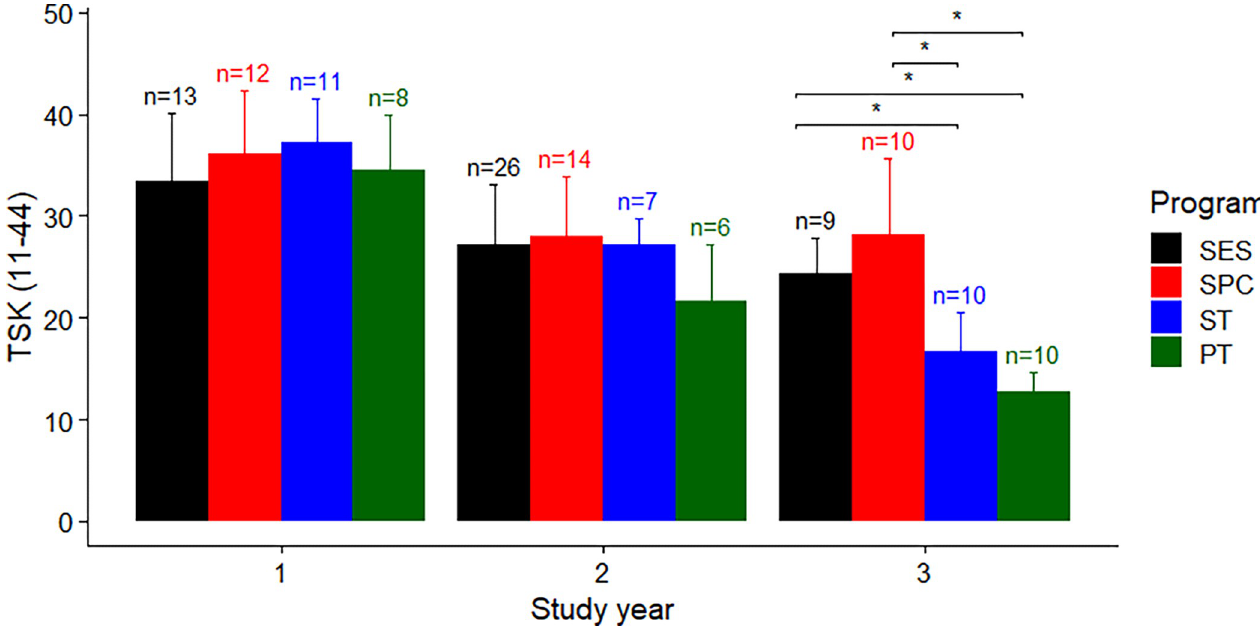
Fig 1. Group average with error bars as one standard deviation of the total score of the Tampa Scale of Kinesiophobia 11-item version, for each study programme and year. * Indicates a statistically significant (P < 0.05) pairwise difference. Abbreviation: SES–Sport and Exercise Science, SPC–Sport and Performance Coaching, ST–Sports Therapy,